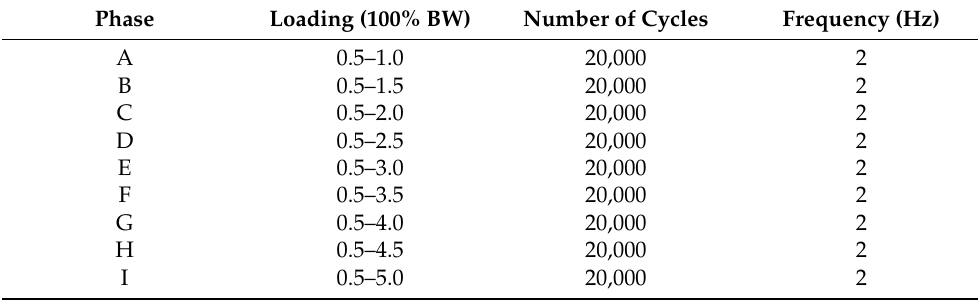
Table 2. The nine cyclic load stages applied to experimental femur-repair